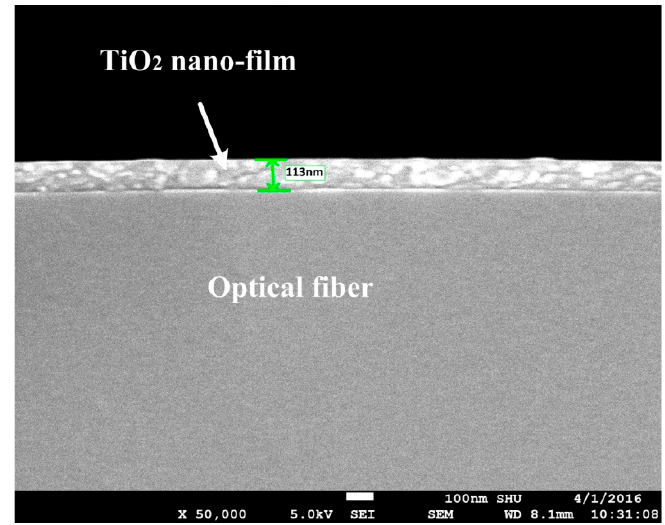
Figure 5. Scanning electron microscopy (SEM) picture of an optical fiber deposited with 3000 layers TiO 2 nanofilm.